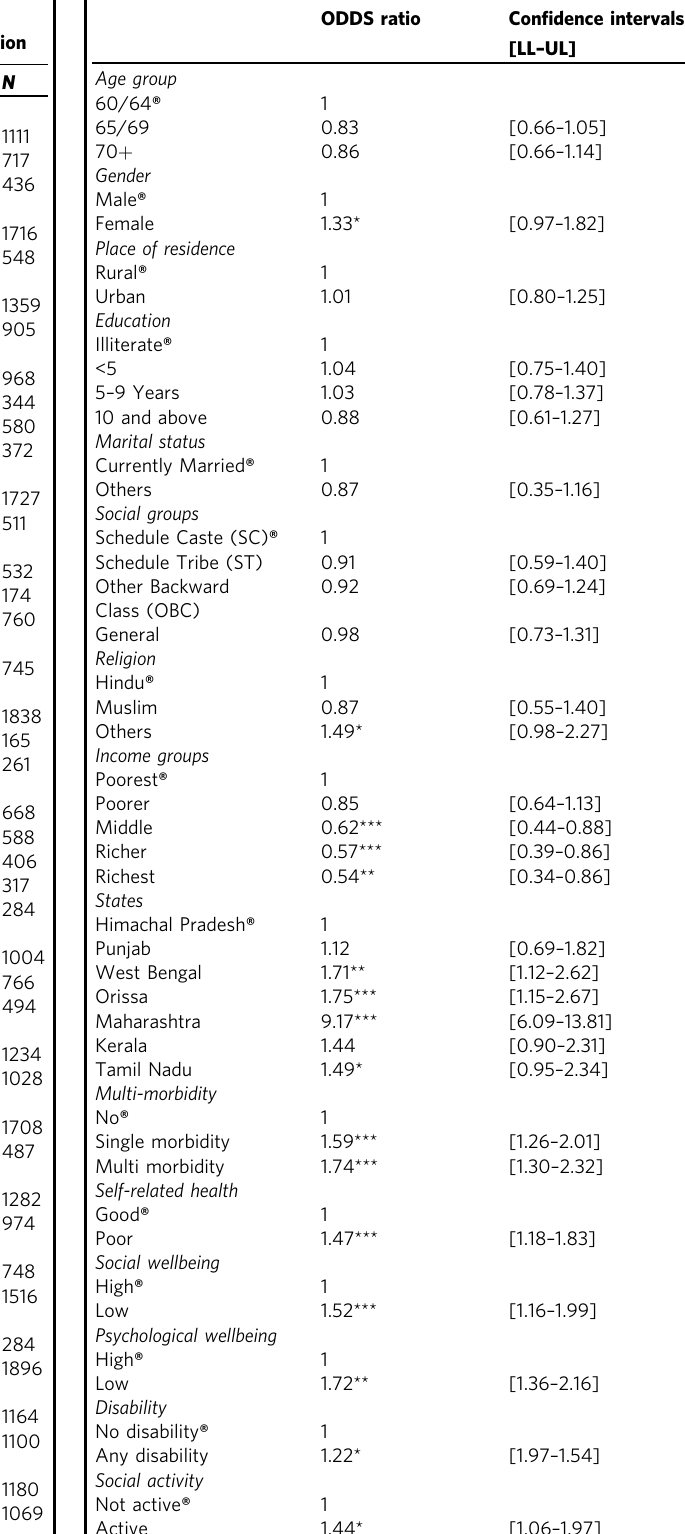
Table 2 Association between work stress and risk factors among elderly in